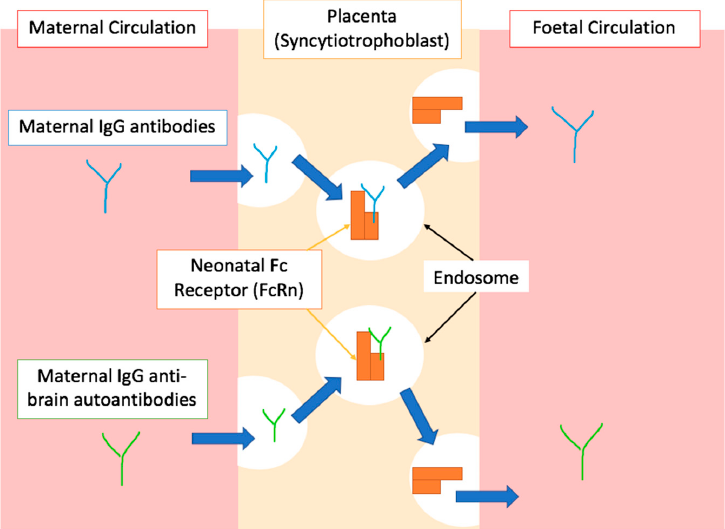
Figure 2. A simplified graphical representation of the placental transfer of IgG antibodies during gestation. The top half of the diagram shows physiological placental transfer of IgG antibodies, mediated by endosomal trafficking after binding to the FcRn. Blue arrows indicate the direction IgG molecules follow through various processes. The bottom half of the diagram shows the proposed mechanism by which IgG autoantibodies reactive to foetal proteins cross the placenta due to the non-specific binding of FcRn to the Fc portion of the antibody as proposed by [38,40,50,51].